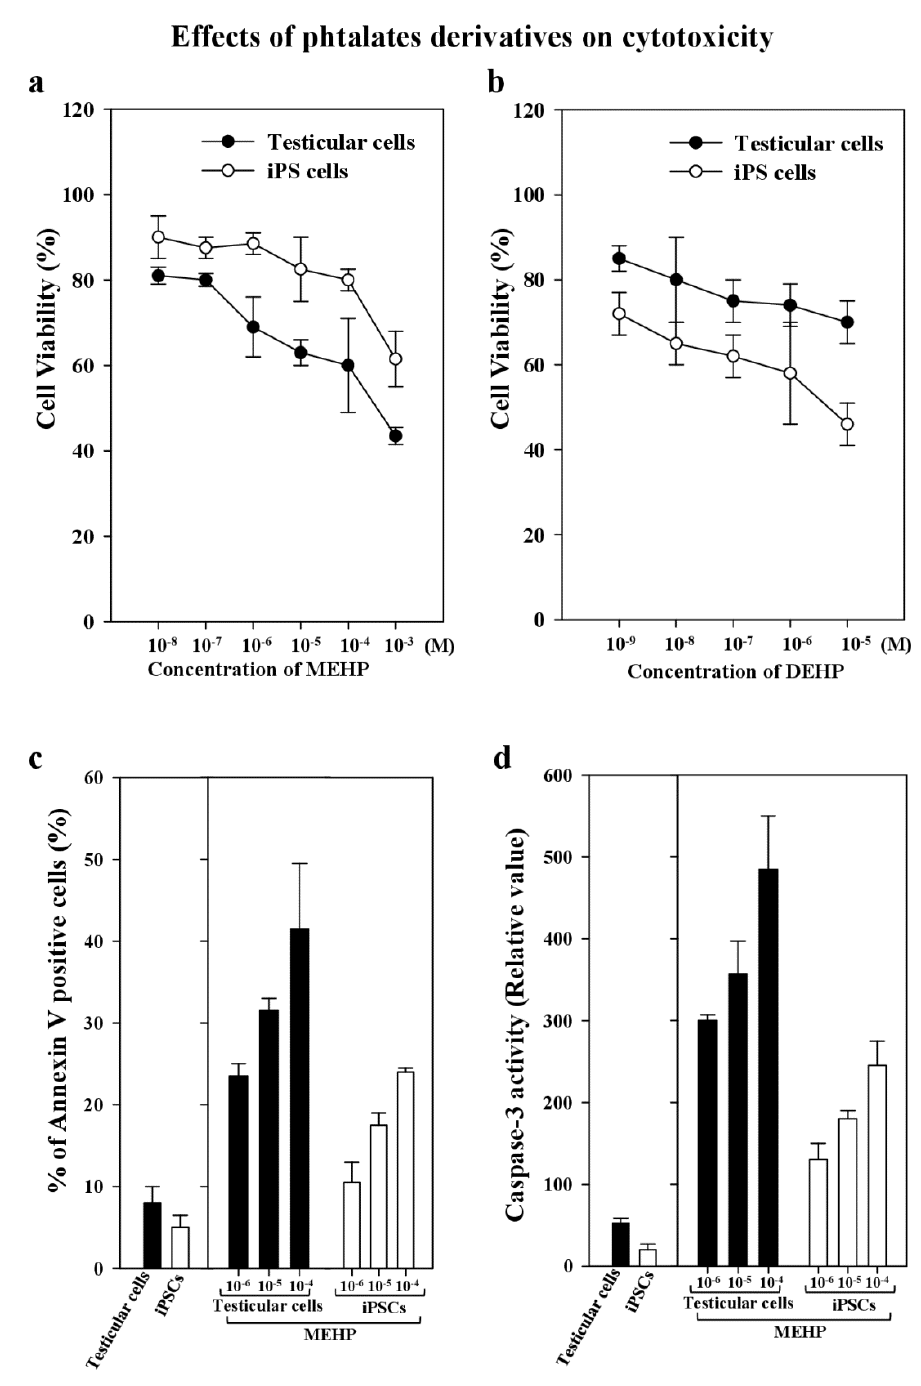
Figure 3. Cell viability and apoptosis induced by phthalate derivatives in bovine testicular cells and iPSCs. ( a ) Cell viability was measured by Trypan Blue staining in the presence or absence of phthalate esters for 24 h; ( b ) Cell viability was measured by Trypan Blue staining in the presence or absence of DEHP for 24 h; ( c ) Apoptotic activity was measured by FITC-labeled annexin V, followed by flow cytometric analysis to identify the apoptotic cells, as described in the Experimental Section; ( d ) Caspase-3 activity in the testicular cells and iPSCs was measured after 10 − 4 –10 − 6 M MEHP and 10 − 7 M staurosporin as a control were added to them for 24 h; and their apoptotic activity was analyzed. Data presented are means ± SD. The statistical analysis was performed with Student’s t